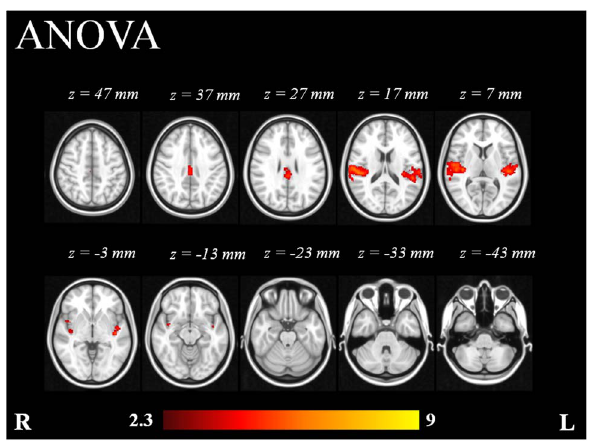
Figure 5. Repeated measures ANOVA analysis (n=16) of 1 factor at 4 levels. Color bar represents Z-scores. doi:10.1371/journal.pone.0109216.g005 operculum cortices, right frontal orbital cortices, right Heschl’s gyrus, right inferior frontal gyrus, right insular cortex, right parietal operculum cortex, right planum polare, right planum temporale, right postecentral gyrus, right precentral gyrus, right putamen, right superior temporal gyrus and right temporal pole.